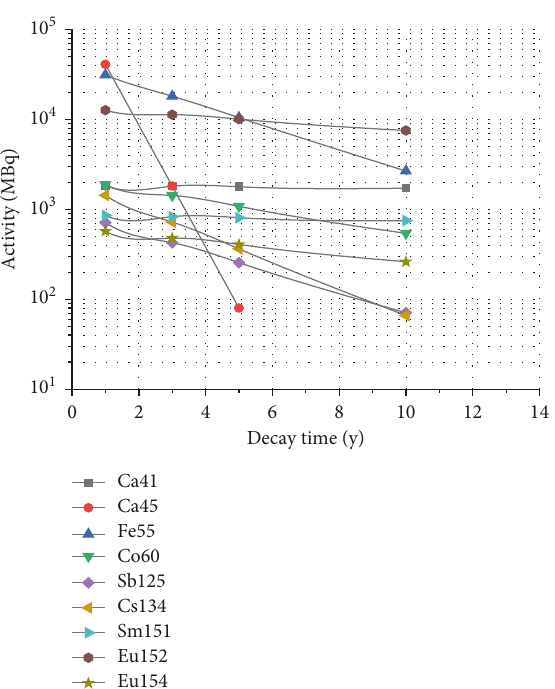
Figure 7: Activity of long-lived nuclides in the biological shield